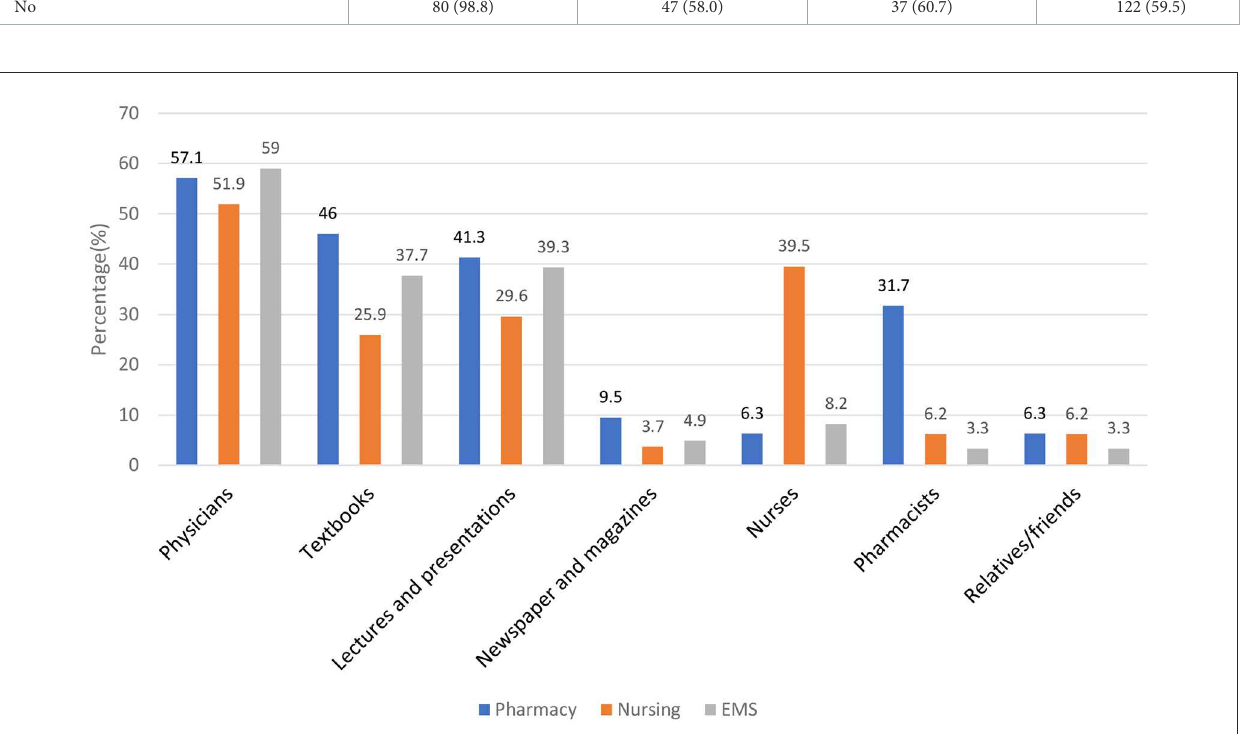
FIGURE2 Source of